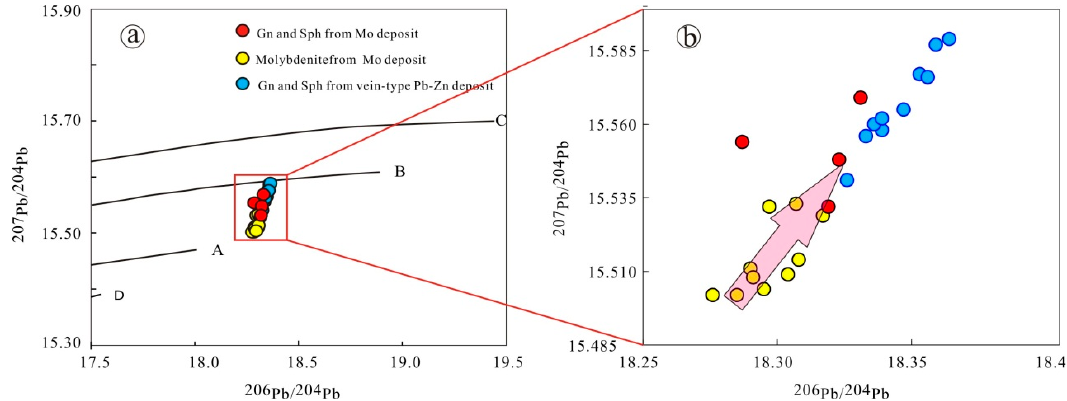
Figure 8. Sulfide Pb composition of both porphyry Mo and adjacent vein-type Pb-Zn deposits in the Diyanqinamu mine. Trends for the Upper Crust (C), Orogenic Belt (B), Mantle (A) and Lower Crust (D) are from Zartman and Doe [56]. Lead isotopic data of the molybdenite separates in Mo ores from Leng et al. [24]. Mineral abbreviations are the same as those in Figure 5. ( a ) Two-stage Pb isotope evolution diagram for sulfides from the Mo and Pb-Zn deposits in the Diyanqinamu mine. ( b ) 206 Pb / 204 Pb versus 207 Pb / 204 Pb diagram.